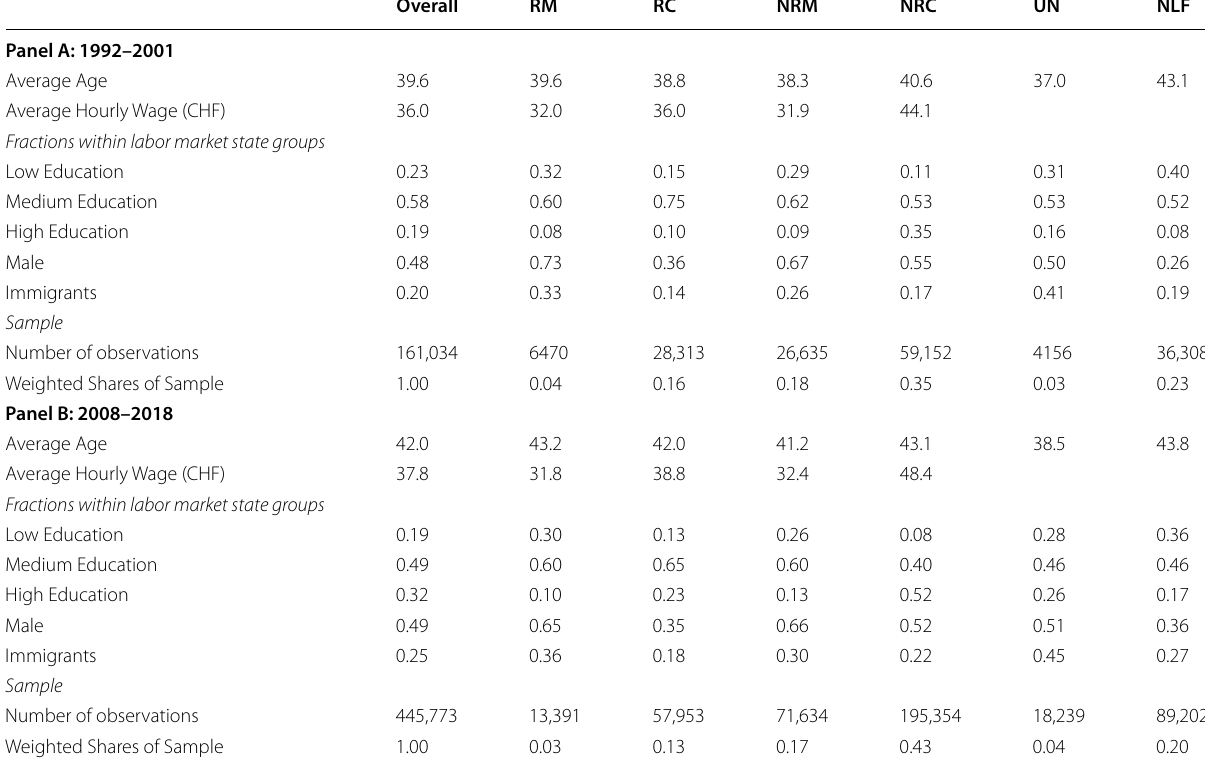
Table 2 Descriptive statistics by labor market